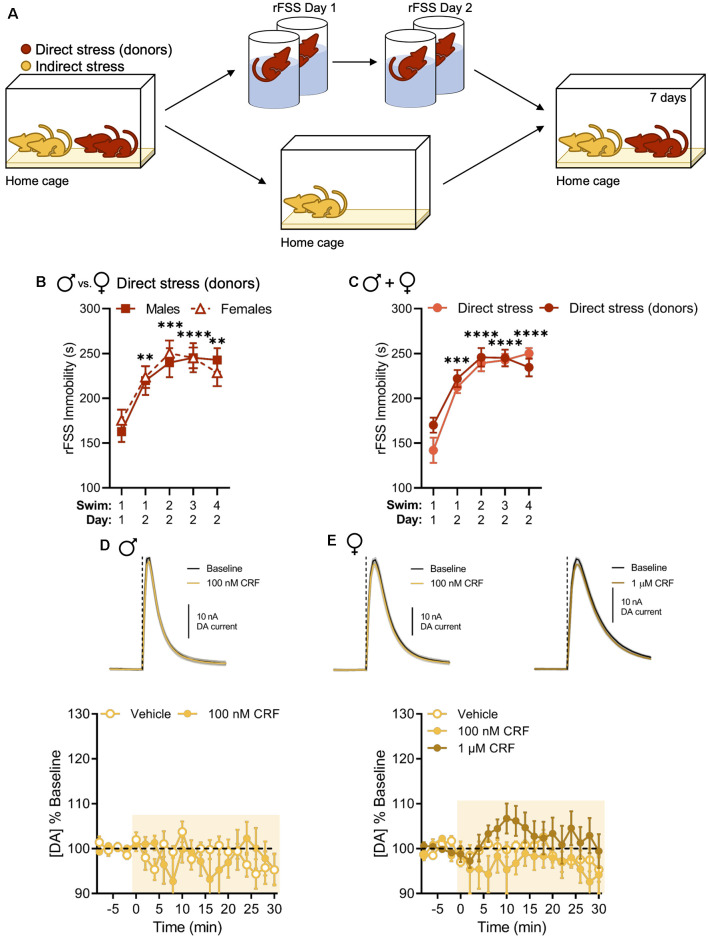
Indirect stress disrupts CRF-mediated dopamine release in the NAc in males and females 1 week after the onset of stress exposure. (A) Mice were housed in groups of four and two mice were subjected to direct stress. The two mice that did not undergo direct stress, termed the indirect stress group, remained in the home cage for the duration of the experiment. (B,C) Cumulative time spent immobile for the first 5 min of Swim 1 on rFSS Day 1 and Swims 1–4 on rFSS Day 2 in panel (B) males (n = 6) and females (n = 8) that were housed with indirectly stressed animals (C) mice (male and female groups combined) belonging to the direct stress (n = 16) and direct stress donors (n = 14) groups. (D) Representative dopamine release evoked by electrical stimulation (dashed line) before and after application of 100 nM CRF to a NAc brain slice (mean ± SEM for five consecutive stimulations, top) and baseline-normalized mean peak amplitude of electrically evoked dopamine release over time in response to vehicle (n = 4) or 100 nM CRF (n = 6) application to NAc slices (bottom) from indirectly stressed males 1 week after cage mates were directly stressed. (E) Representative dopamine release evoked by electrical stimulation before and after application of 100 nM CRF (top, left) or 1 μM CRF (top, right) to a NAc slice (mean ± SEM for five consecutive stimulations) and baseline-normalized mean peak amplitude of electrically evoked dopamine release over time in response to vehicle (n = 8), 100 nM CRF (n = 5), or 1 μM CRF (n = 8) application to NAc slices (bottom) from indirectly stressed females 1 week after cage mates were directly stressed. Error bars, SEM. **P < 0.01, ***P < 0.001, ****P < 0.0001 vs. rFSS Swim 1 Day 1 immobility.